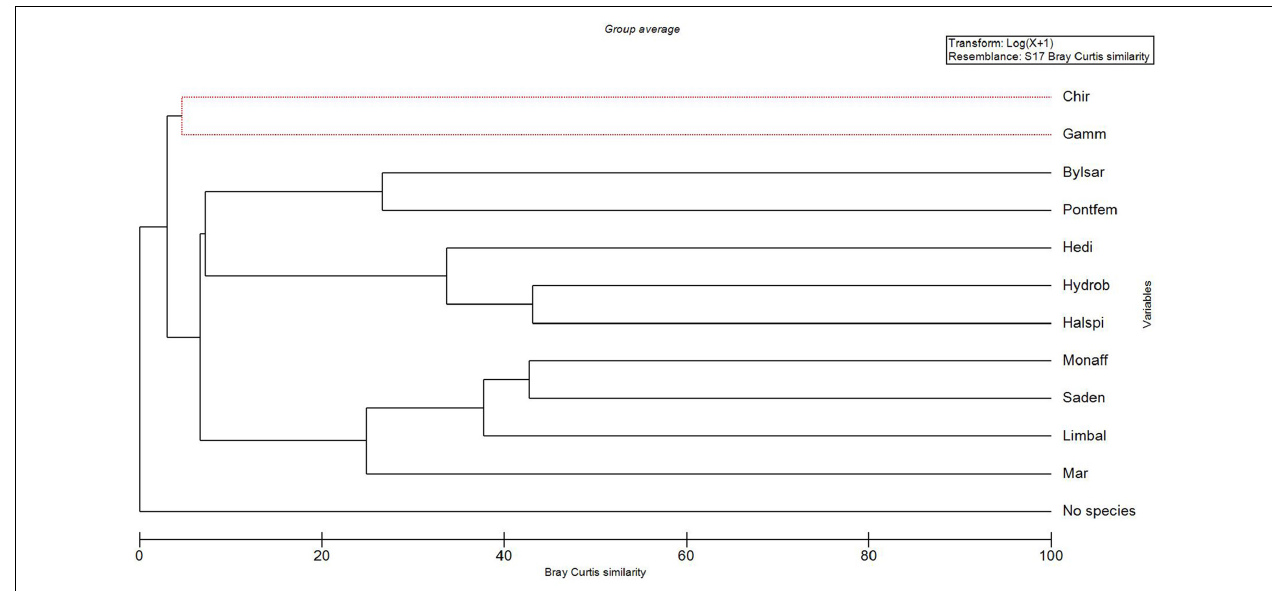
FIGURE 3 | A cluster dendrogram output of the SIMPROF-test (see Table 1 ) with Bray Curtis similarity measure ( x -axis) and variables ( y -axis). “No species” refers to samples with lacking macro-benthic specimens. Taxa abbreviations: Mar – Marenzelleria spp., Limbal – Limecola ( Macoma ) balthica , Saden – Saduria entomon , Monaff – Monoporeia affinis , Hedi – Hediste diversicolor , Halspi – Halicryptus spinulosus , Hydrob = Hydrobia spp., Bylsar – Bylgides sarsi , Pontfem – Pontoporeia femorata , Gamm – Gammarus spp., Chir – Chironomidae. The red dashed lines refer to variables which cannot be significantly differentiated.